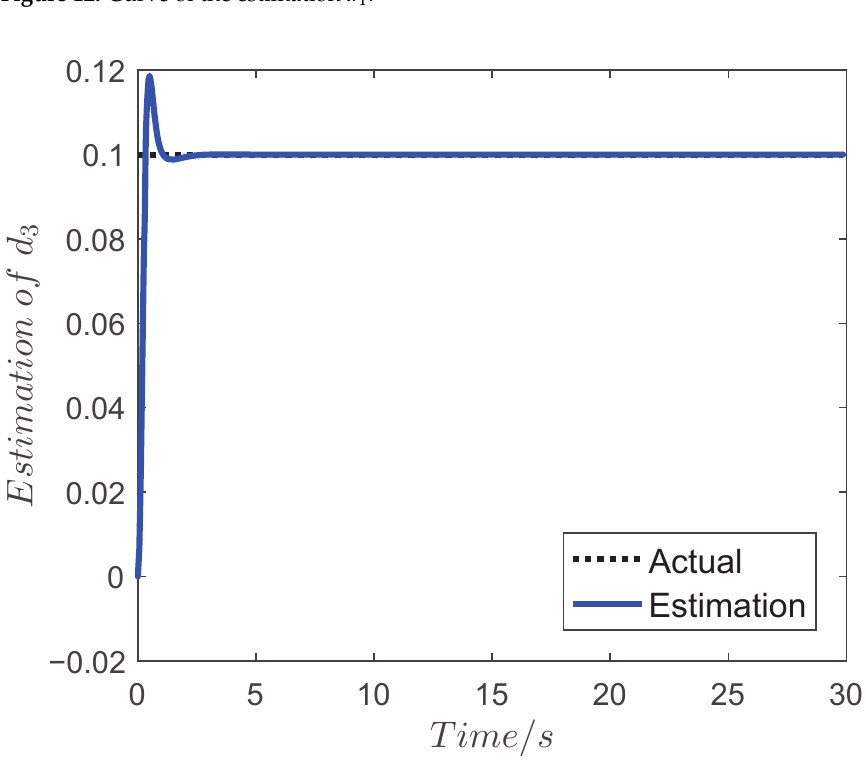
Figure 12. Curve of the estimation d 1 .